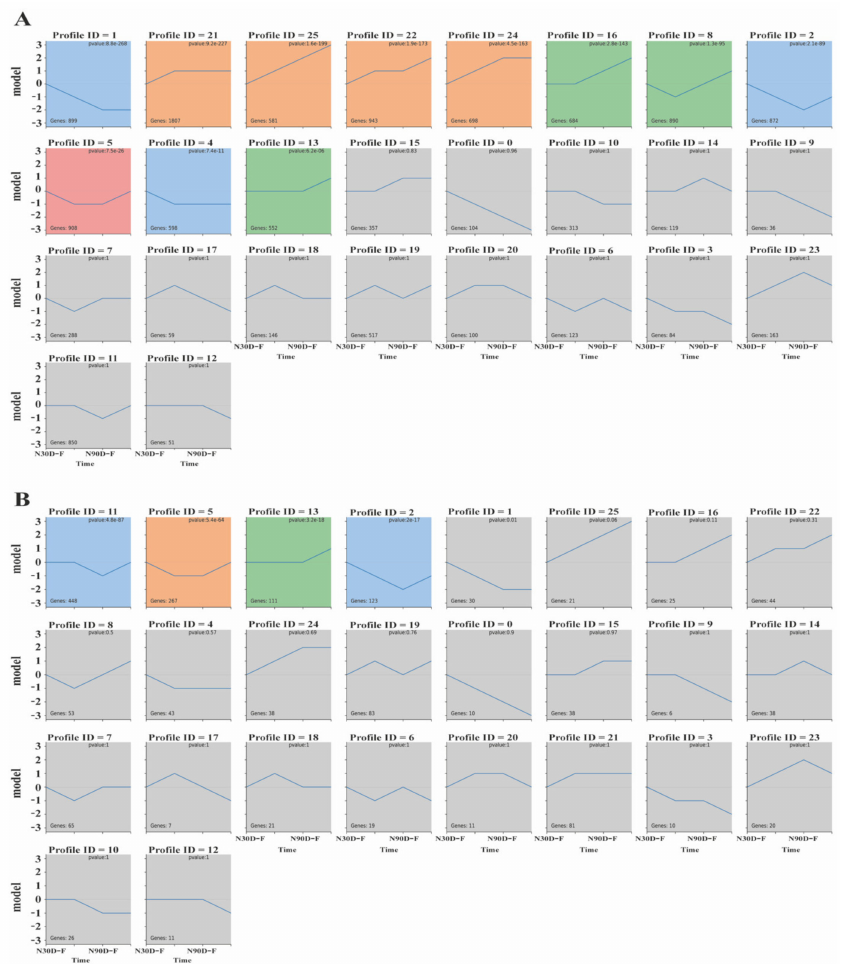
Figure 3. Short Time-series Expression Miner identified temporal expression profiles of ( A ) mRNAs and ( B ) lncRNAs. The top panel indicates the module number; numbers at the top right corner indicate p -value; numbers at the bottom left represents mRNAs or lncRNAs in each profile module.